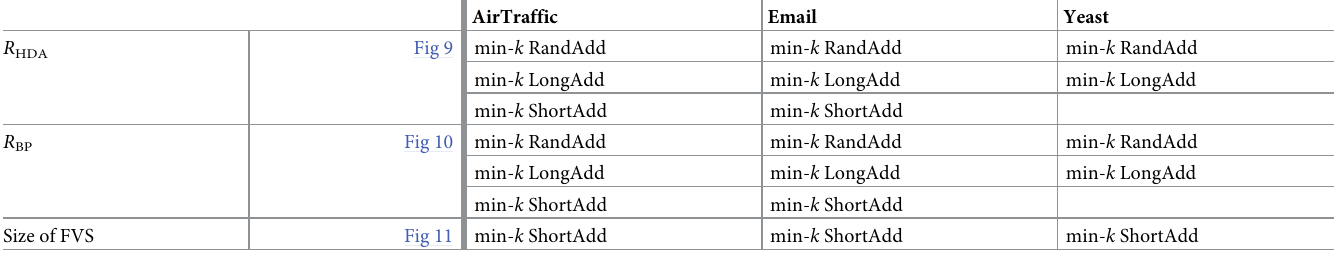
Table 4. The most effective methods for improving R HDA , R BP , and the size of FVS to real